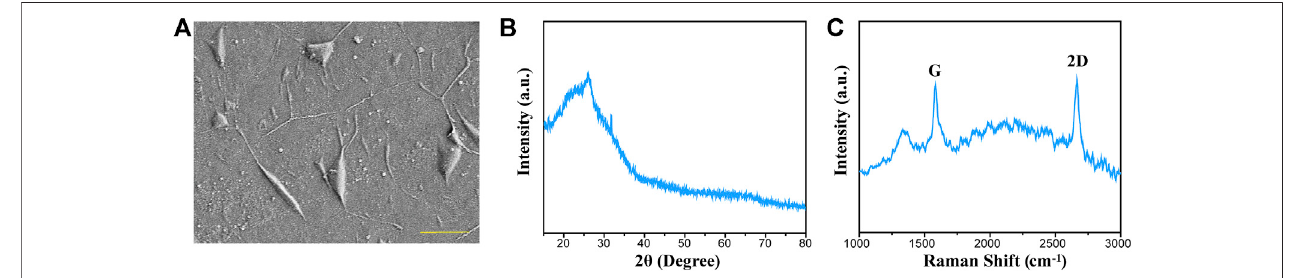
FIGURE1| CharacterizationofgraphenesubstratespreparedbytheCVDmethod. (A) RepresentativeSEMimageofthegraphenesubstrates. (B) XRDspectrafor graphene substrates. (C) Raman spectra for graphene substrates.